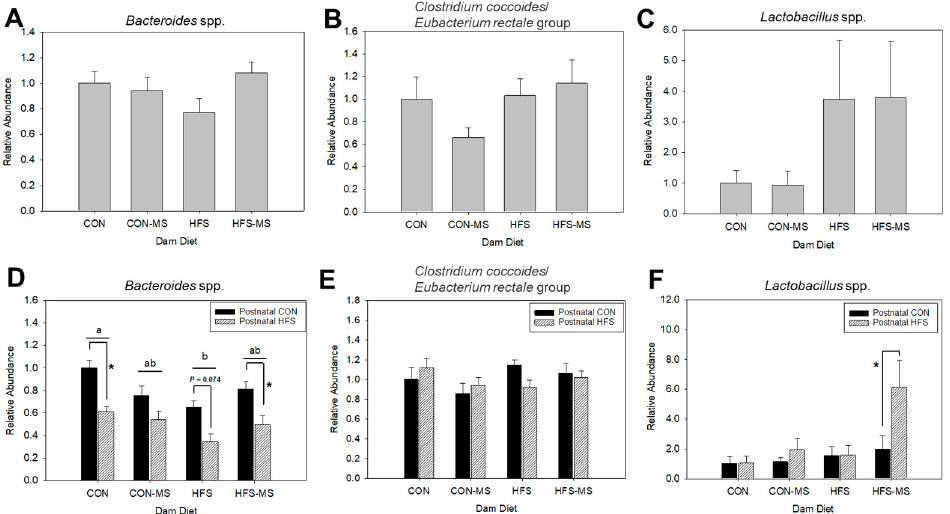
Figure 4. Relative abundance of Bacteroides spp. ( A , D ), Clostridium coccoides/Eubacterium rectale group ( B , E ), and Lactobacillus spp. ( C , F ) in weanling ( A – C ) and adult ( D – F ) offspring born to dams fed control (CON) or high-fat, high-sucrose (HFS) diets with or without methyl-donor nutrient supplementation (MS). Data are normalized to Eubacteria and expressed in relative to pups of CON dam (weanling) or pups of CON dams fed a postnatal CON diet (adult). All data are pooled from both sexes. Different letters indicate significant differences between dam diets at p < 0.05. * Indicates significant difference between pup’s diets at p < 0.05. Data are expressed as mean ± SEM ( n = 6–10/group). Postnatal CON, control postnatal diet; Postnatal HFS, high-fat, high-sucrose postnatal